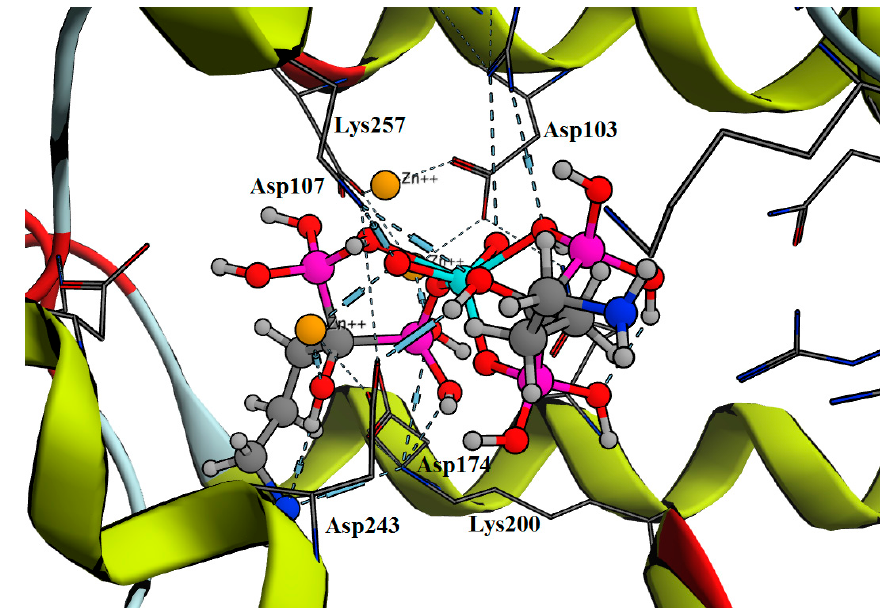
Figure 5. The predicted orientation of Tc-alendronate complex.